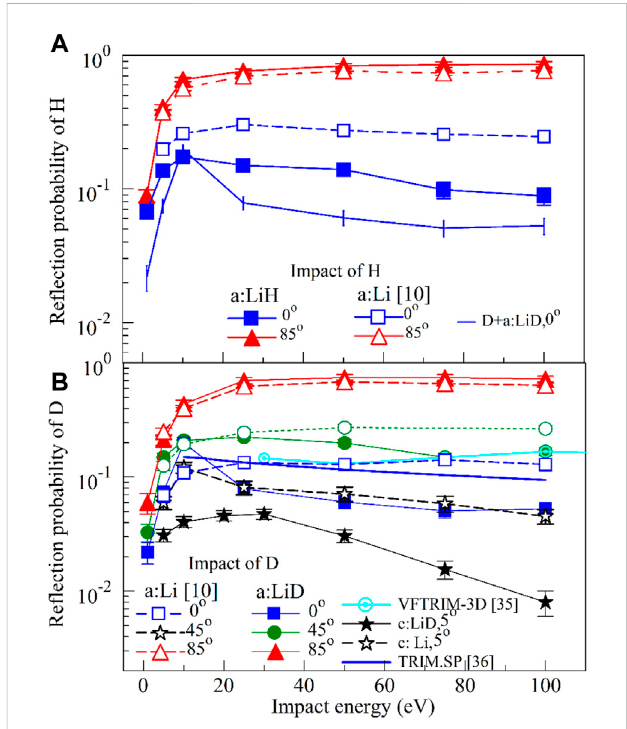
FIGURE 3 The probabilities of re fl ection per impact ( P R ) of H and D at amorphous surfaces at 300 K, for impact energies in the range 1 – 100 eV, and for various incident angles. (A) Comparison of P R for H impacts at (A) LiH surfaces for the impact of H at 0 ° and 85 ° . The P R for impact of H at the (A) Li surface [10], as well as for D+a:LiD at 0 o for isotopeeffects,arealsoshownfor comparison. (B) Comparison of P R for D impacts at (A) LiD and (A) Li surfaces for the impact of D at 0 ° , 45 o , and 85 ° and at crystalline (C) LiD and (C) Li surfaces at a 5 o incident angle. Shown probabilities are averages over all successful trajectories, with error bars being maximal standard errors. The VFTRIM-3D data for the re fl ection of D from an amorphous LiD surface at an incident angle of 45 o [35], and TRIM.SP [36] data for D+a:Li at 0 o are also